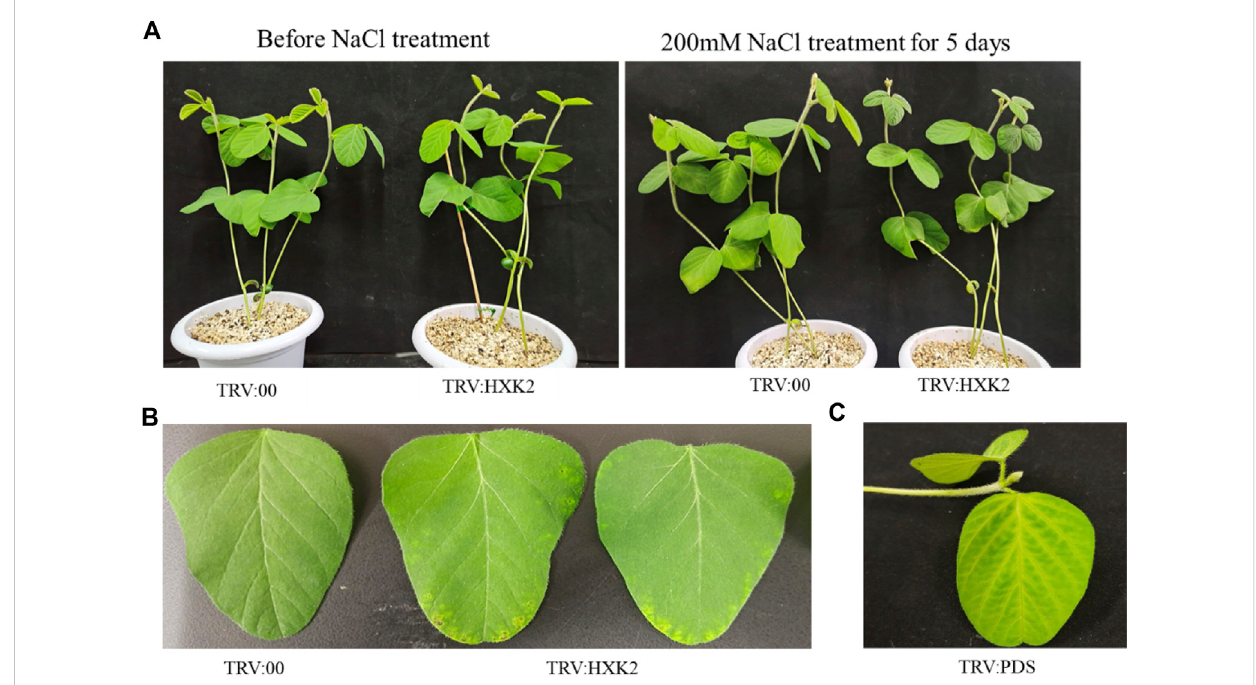
FIGURE 6 Phenotypic analysis of GmHXK2 -silencing soybeans under salt stress. The seedings of TRV:00 and TRV: HXK2 divided into two groups (control and salt treatment) were grown for 7 days on pot under normal condition, then the plants were treated with 0 or 200 mM NaCl for 5 days, respectively. Salt treatment group phenotype as shown in fi gure (A – C) Phenotypes of TRV:00, TRV: HXK2 and TRV: PDS .